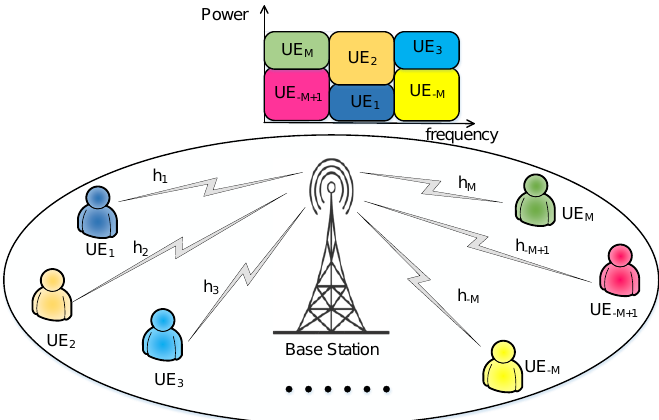
Figure 1. The proposed downlink NOMA system model for single-cell transmission.